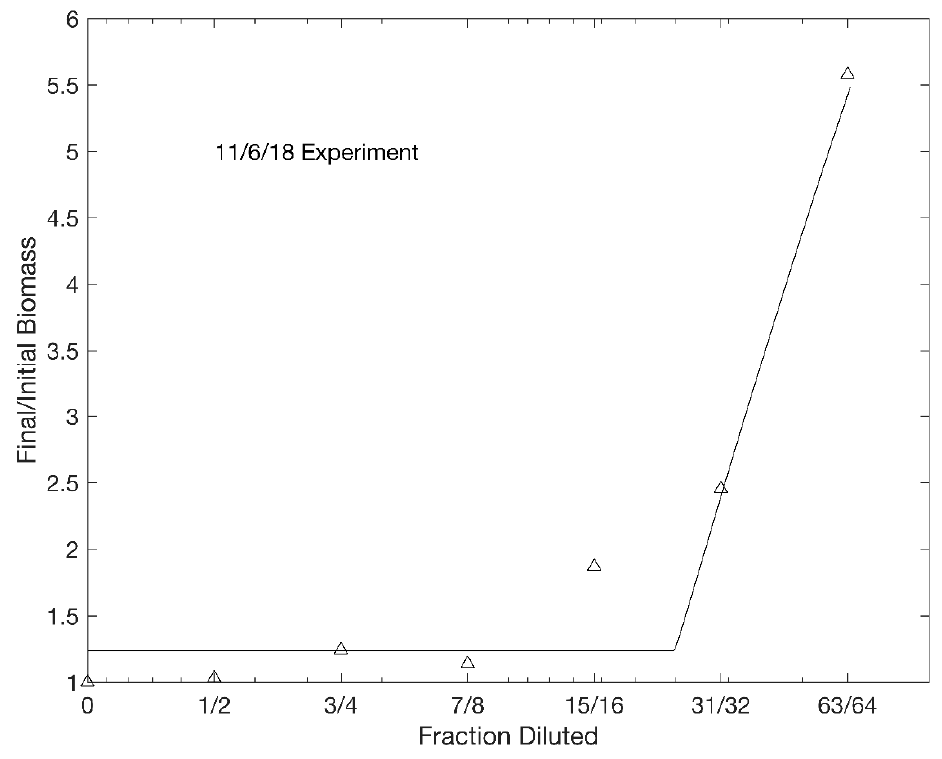
Figure 2. Results of the dilution experiment with University Lake water conducted on 6–7 November 2018. Triangles are experimental data. The smooth curve is the result of numerically integrating Equations. 1–2 with constants chosen to give the best fit in a least-squares sense to the data. Note that the abscissa is scaled so that the intervals between the diluted fractions are equal.